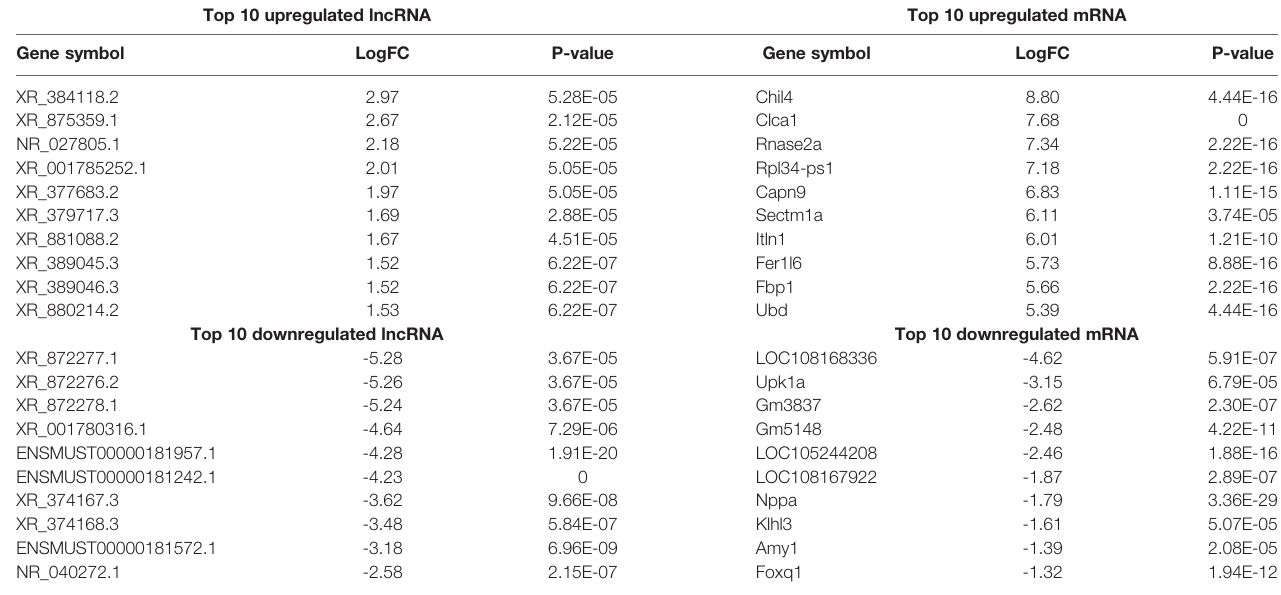
TABLE 1 | Top 10 differentially expressed lncRNAs and mRNAs between the control group and WT-PCP group. Top 10 upregulated lncRNA Top 10 upregulated mRNA Gene symbol LogFC P-value Gene symbol LogFC P-value